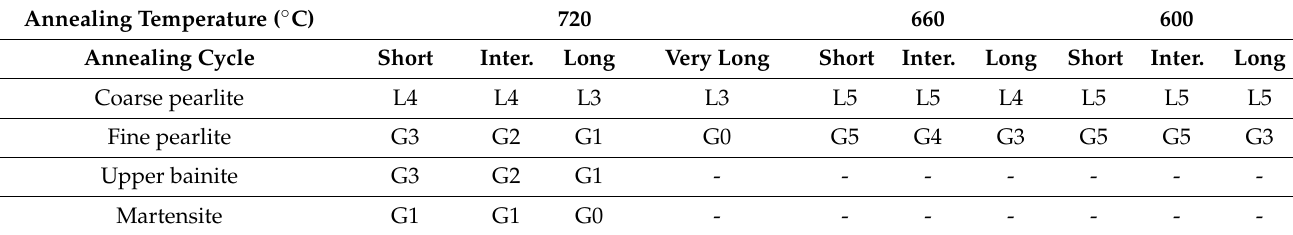
Table 1. Spheroidization rating of the annealed microstructures according to the ASTM F2282 standard. Annealing Temperature ( ◦ C) 720 Annealing